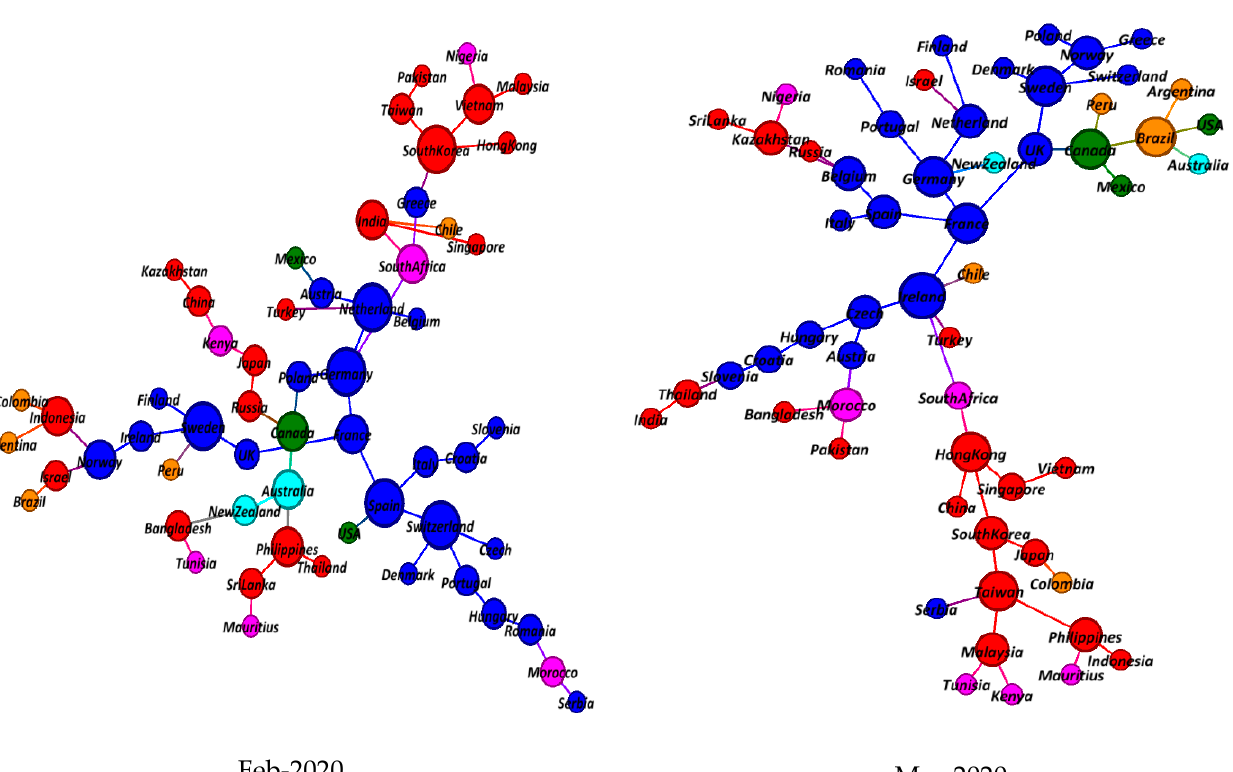
Figure 2. Comparison of dynamics MSTs of the world stock market network from December 2019 to March 2020.